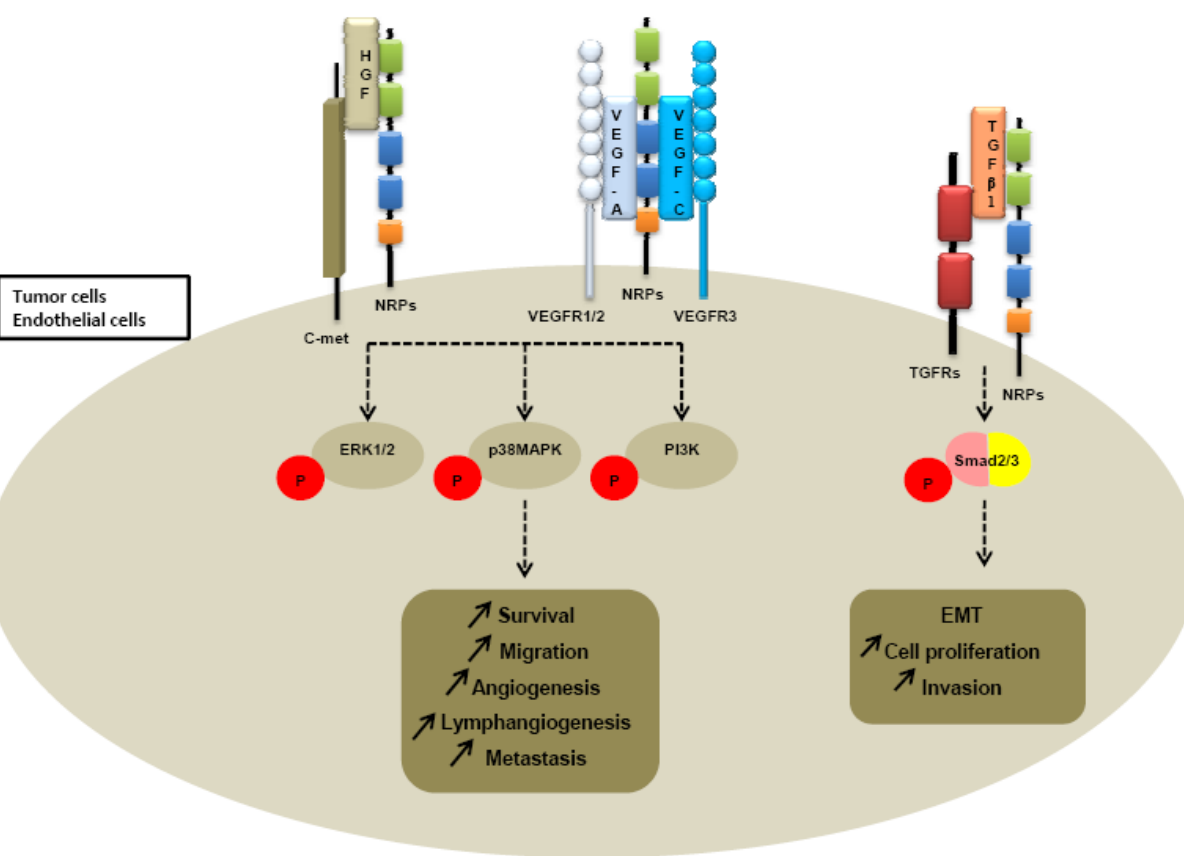
Figure 4. NRPs interactions with growth factor